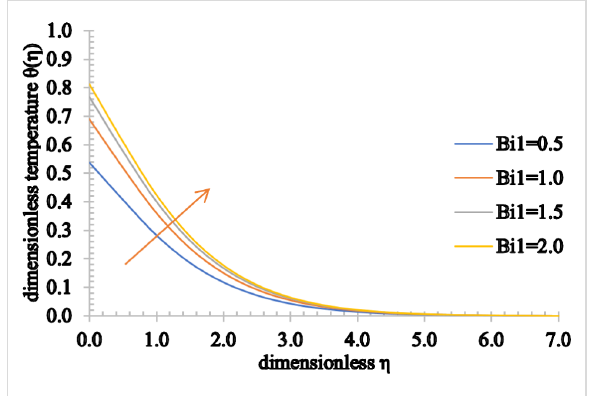
Figure 22: The temperature profile for increasing values of Bi 1.